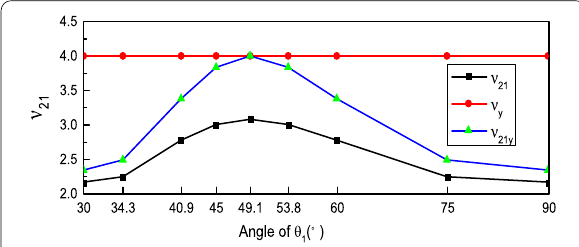
Figure 13 Poisson’s ratio with varying θ 1 angle in the σ 2 direction